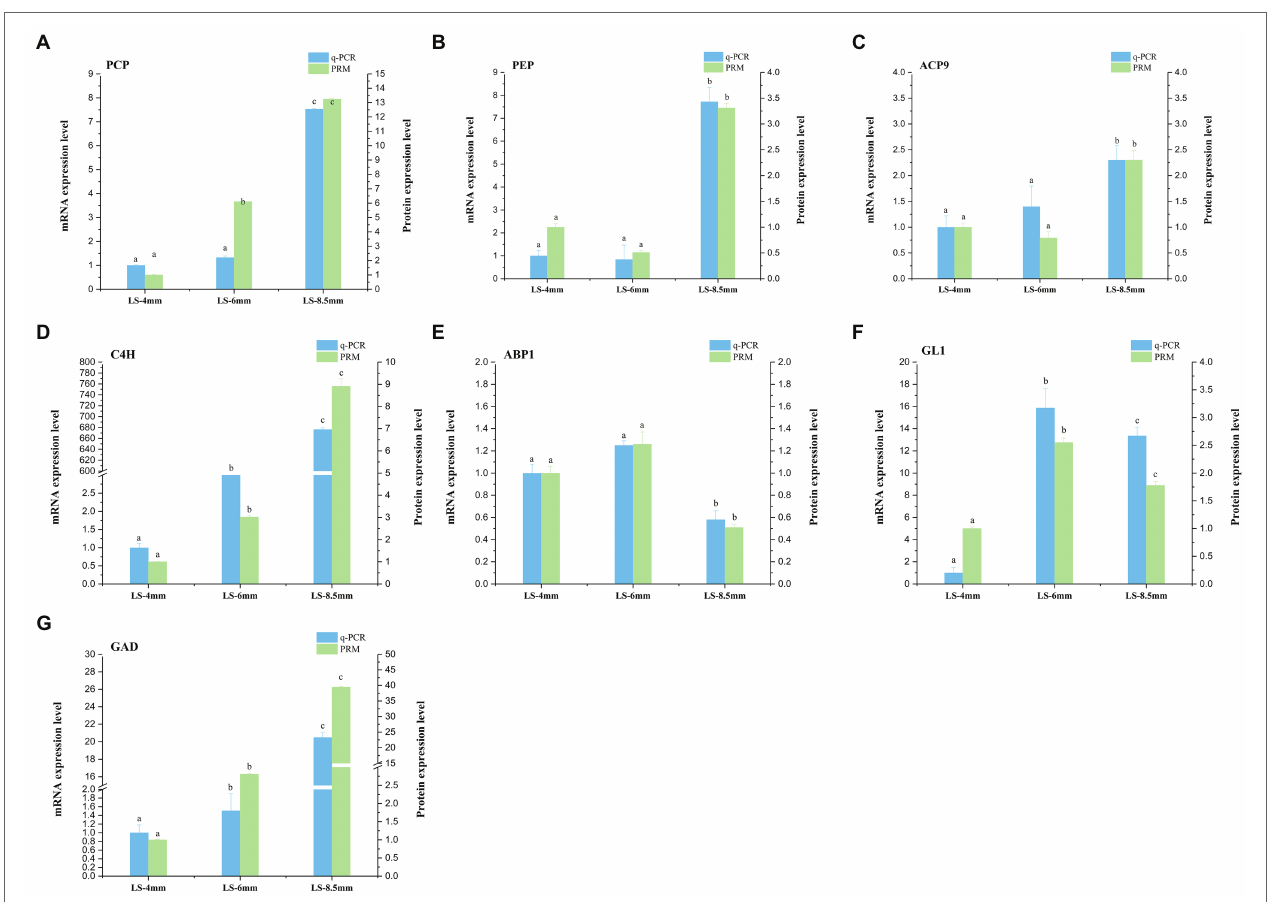
FIGURE 9 | qRT-PCR and parallel reaction monitoring (PRM) of genes and proteins involved in in the metabolic pathways by which fatty acids are converted to sugars. Samples were obtained from 4-, 6-, and 8.5-mm spikelets in O. longistaminata . (A–G) represents qRT-PCR and PRM results of key enzymes PCP, PEP, ACP9, C4H, ABP1, GL1 and GAD, respectively. Relative gene expression and relative protein rates of each sample were compared to those in 4-mm spikelets. Actin was used as the internal reference gene with the 2 −ΔΔ C T method. Gene expression is shown in red and protein level in green. The data are means of three biological replicates, and different lowercase letters represent significant differences between stages within the same graph panel ( p <